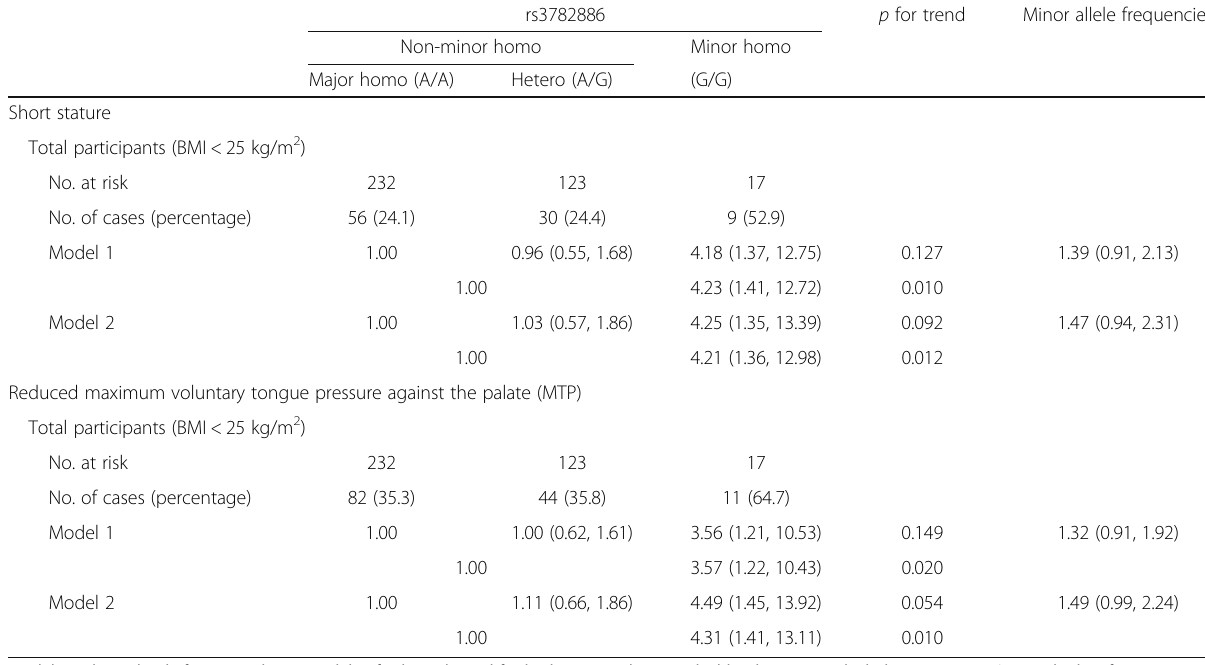
Model 1: adjusted only for sex and age. Model 2: further adjusted for body mass index, systolic blood pressure, alcohol consumption (never drinker, former drinker, current drinker [<23, 23 – 45, 46 – 68, and ≥ 69 g/week]), smoking status (never smoker, former smoker, current smoker), history of stroke, HDL-cholesterol, triglycerides, HbA1C, and serum creatinine. Short stature is defined as a height level at or under the 25th percentile of the study population (<158.0cm for men and <145.0 cm for women). Reduced maximum voluntary tongue pressure against the palate is defined as the lowest tertile of the study population (<26.5 kPa for men and <24.1 kPa for